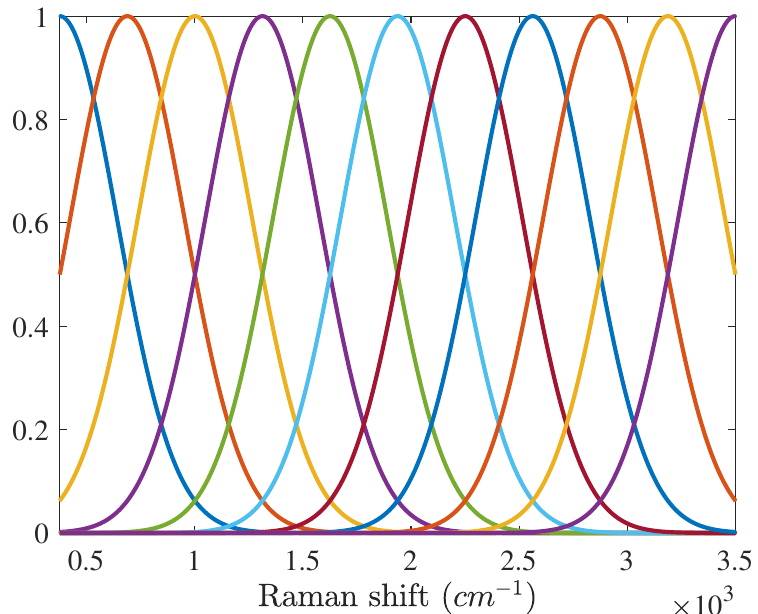
Figure 1. Eleven broad Gaussian vectors used in the experiment. The center interval of each Gaussian vector is 312 cm − 1 and the variance of each Gaussian vector is 265 cm −